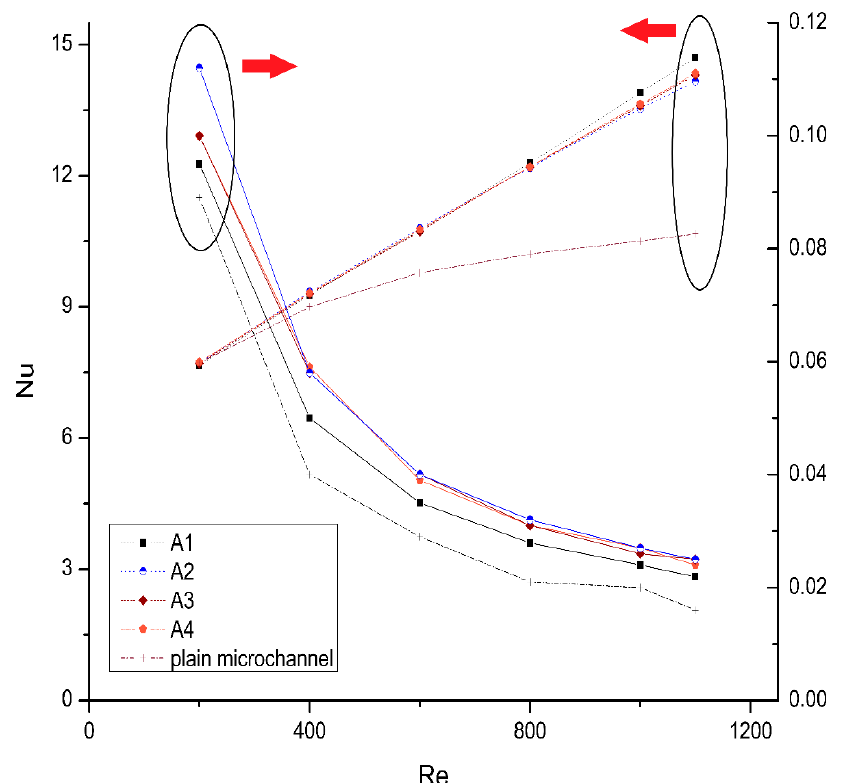
Figure 10. Nusselt number and Fanning friction factor versus Reynolds number for various microchannel configurations.